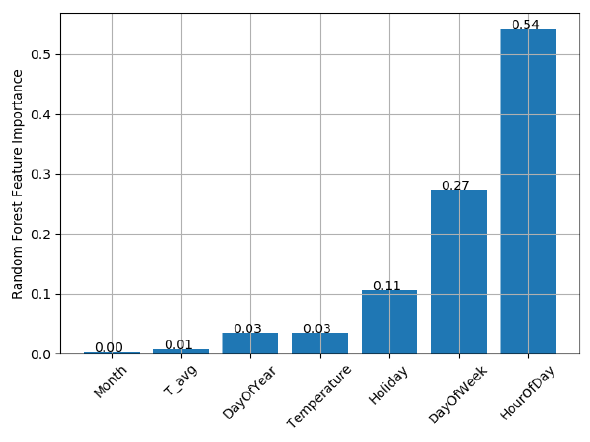
Figure 6. Data features’ importance in the random forest regression for the adapted data series.